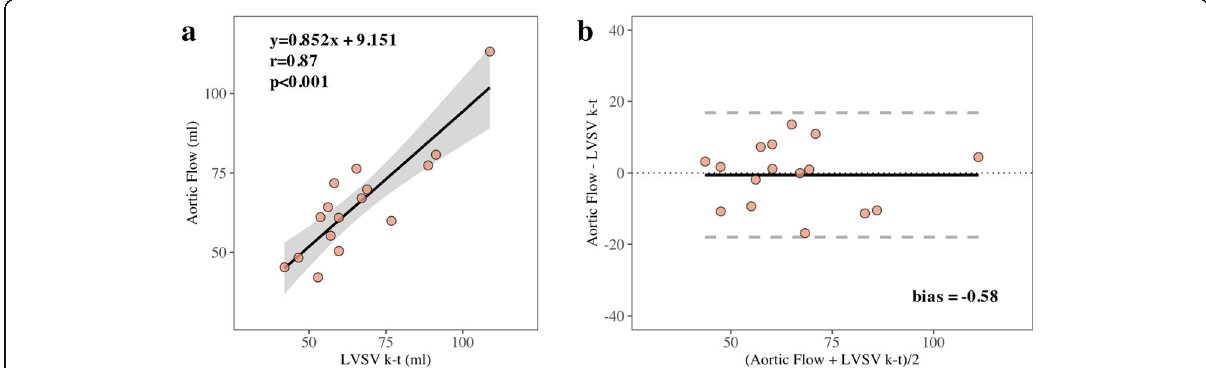
Fig. 4 Validation analysis for quantification of stroke volume by accelerated k-t SENSE versus aortic forward flow. Correlation ( a ) and Bland-Altman analysis ( b ). LVSV left ventricular stroke volume